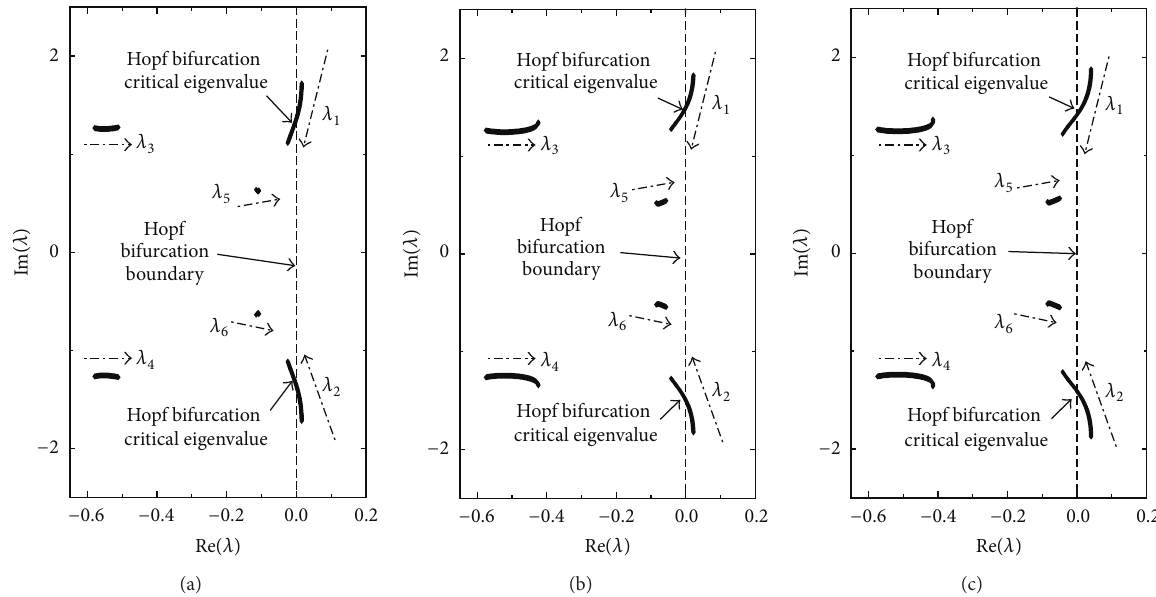
Figure 8: Eigenvalue loci as 𝑋 5 decreases from 0.9 to 0.1 at (a) 𝑉